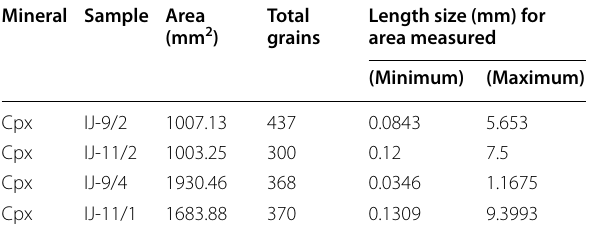
Table 1 Crystal size distribution (CSD) of Cpx of ijolites in the Sung Valley UACC Mineral Sample Area (mm 2 )